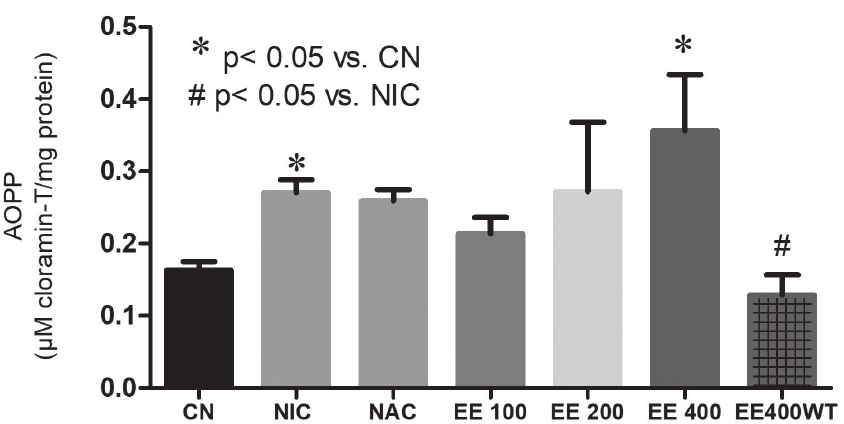
FIGURE 3 - AOPP level of mice treated for 5 days prior to the induction of NIC. Groups: CN, negative control; NIC, contrast nephropathy, NAC, 100 mg/kg N -acetylcysteine; EE100, 100 mg/kg E. edulis + NIC; EE200, 200 mg/kg E. edulis + NIC; EE400,